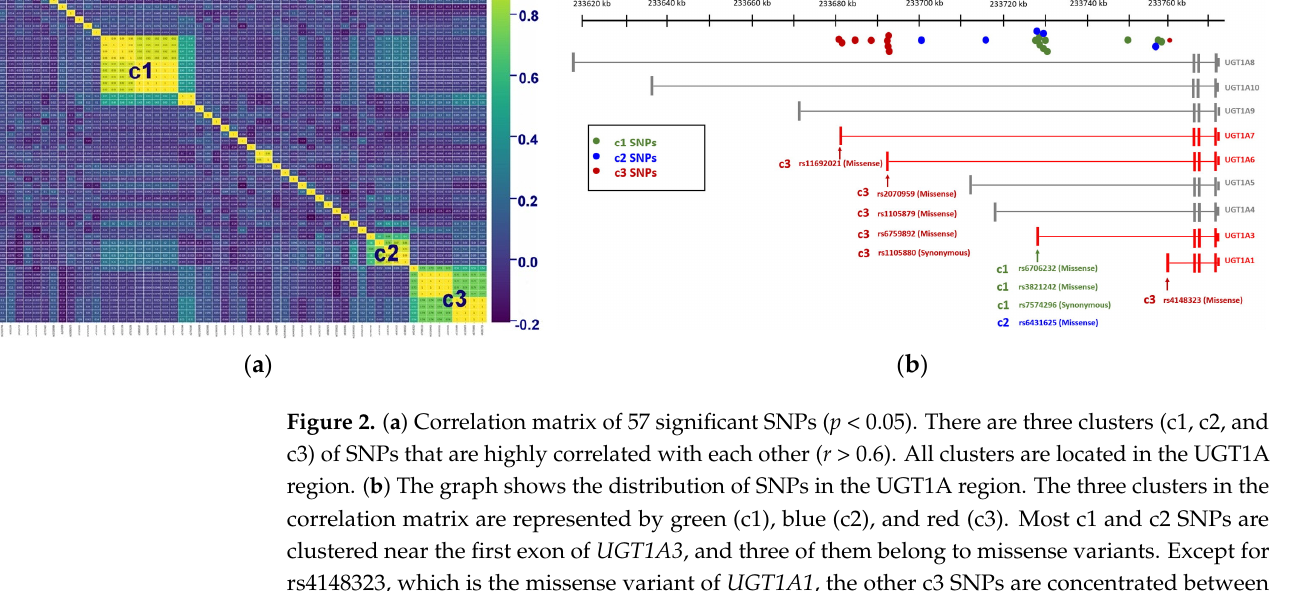
Table 2. The information on SNPs among these tree clusterings which having a high correlation with each other.